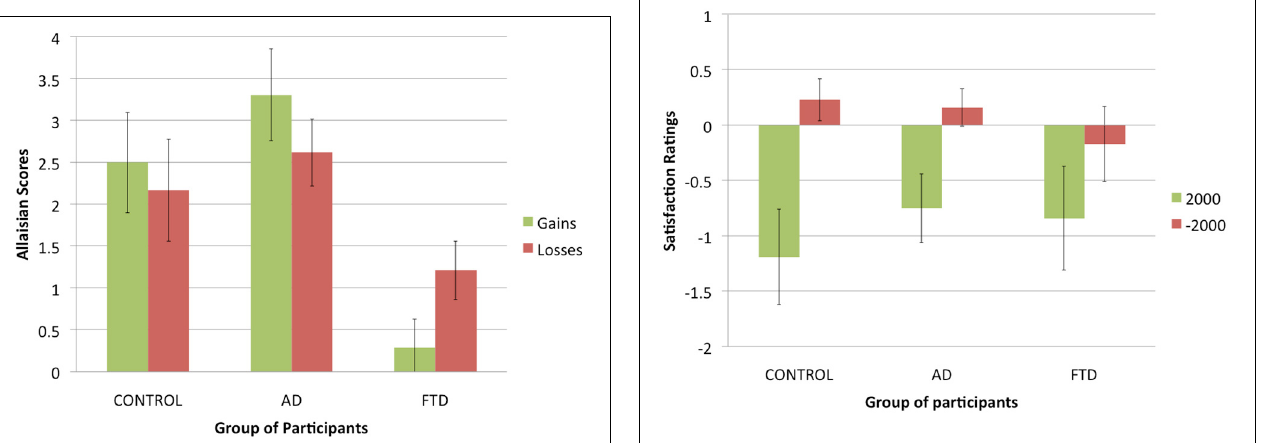
FIGURE 2 | Allaisian scores in function of group of participants and condition (error bars indicate standard error).